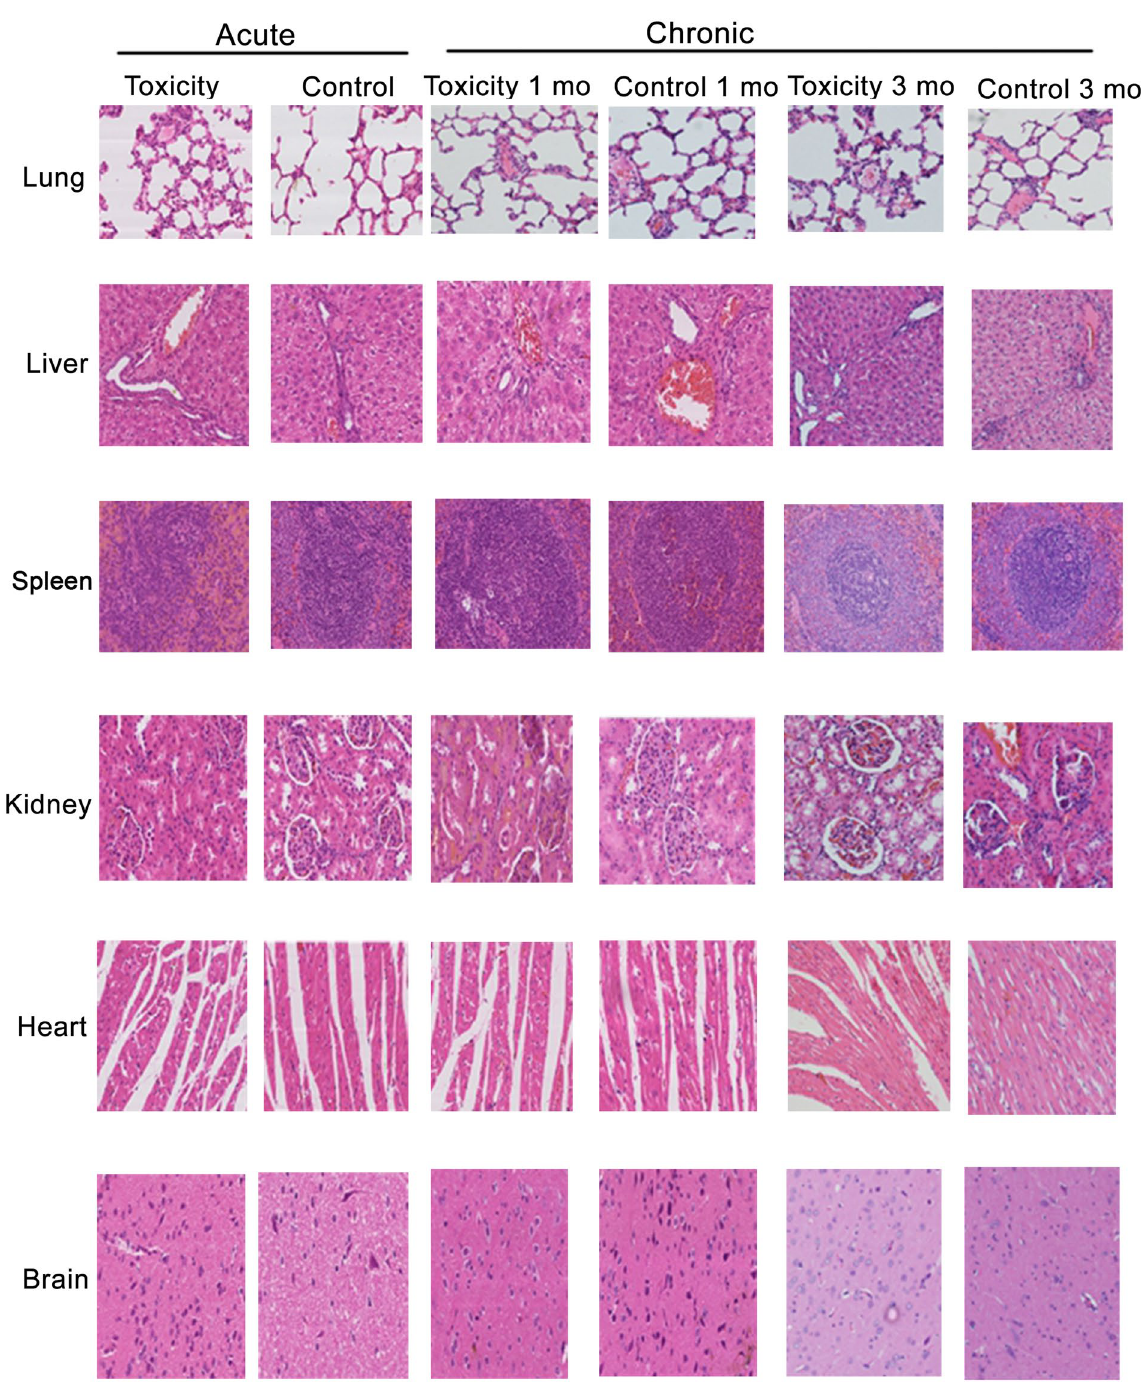
Figure 7. Nb4 showed low toxicity in rats. For the evaluation of acute Nb4 toxicity, rats (4-week old) were injected with 10 mg/kg Nb4 (10-fold higher than the normal dose) via the tail vein, or injected with equal volume of saline. One week after the injection, liver and kidney functions and the pathologic changes in the heart, liver, spleen, lung, kidney, and brain were examined. For the assessment of chronic Nb4 toxicity, rats were injected with Nb4 (1 mg/kg) via the tail vein once daily for one month or 3 months. Rats in the control group received an equal dose of normal saline. Liver and kidney functions and the pathologic changes in the heart, liver, spleen, lung, kidney, and brain were